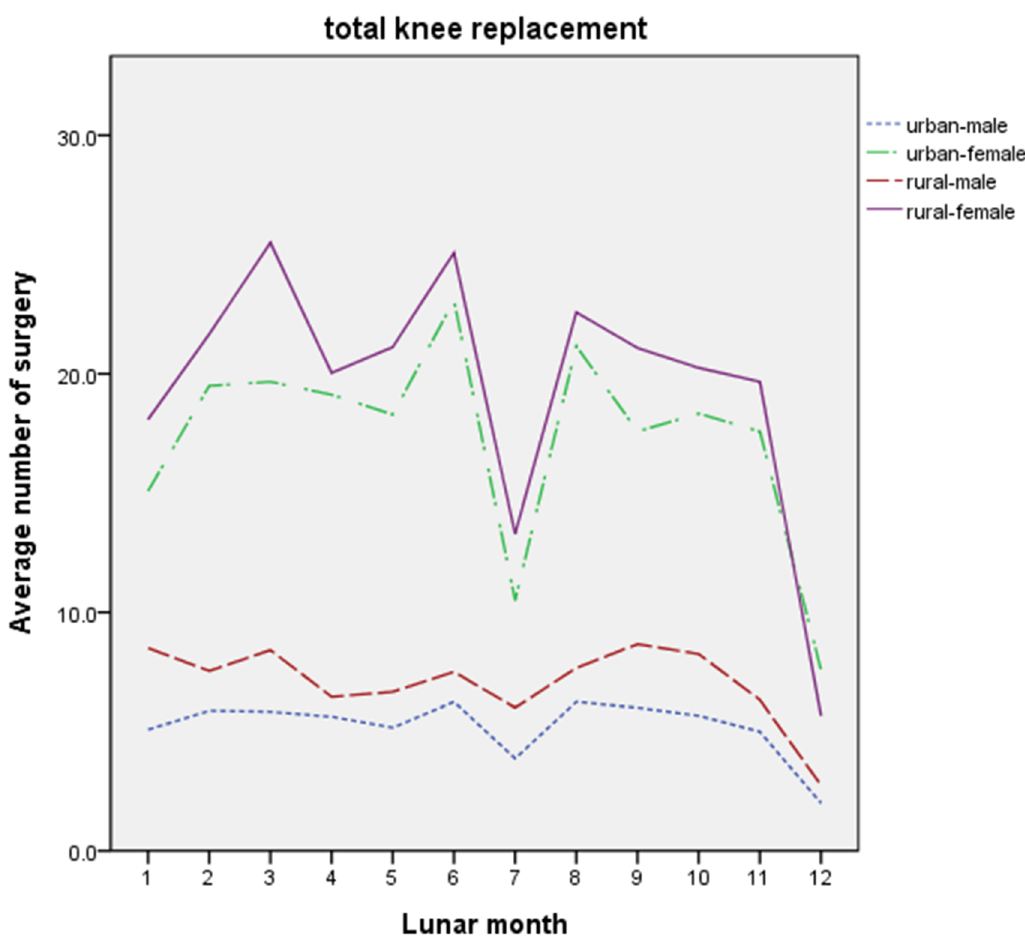
Fig 1. Average numbers of TKR surgeries categorized by location of residence and gender of patients in each lunar month from 2000 to 2011. X-axis: the 12 lunar months; Y-axis: the average number of the TKR surgeries. TKR: total knee replacement.